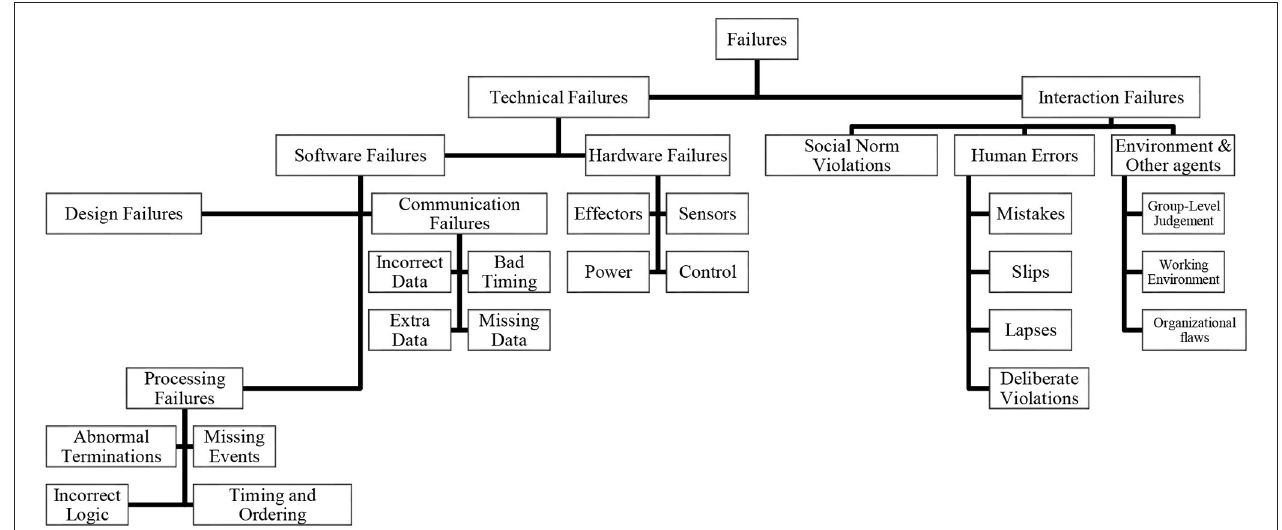
FIGURE 1 | A human-robot failure